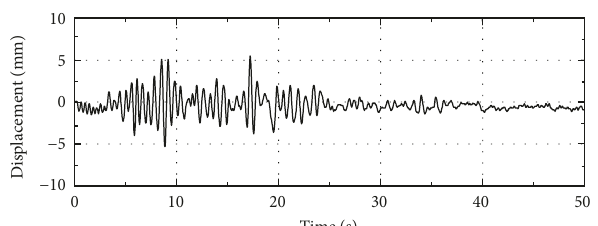
Figure 16: Displacement response curve of intensity 7 frequently of Alaska (transverse input).